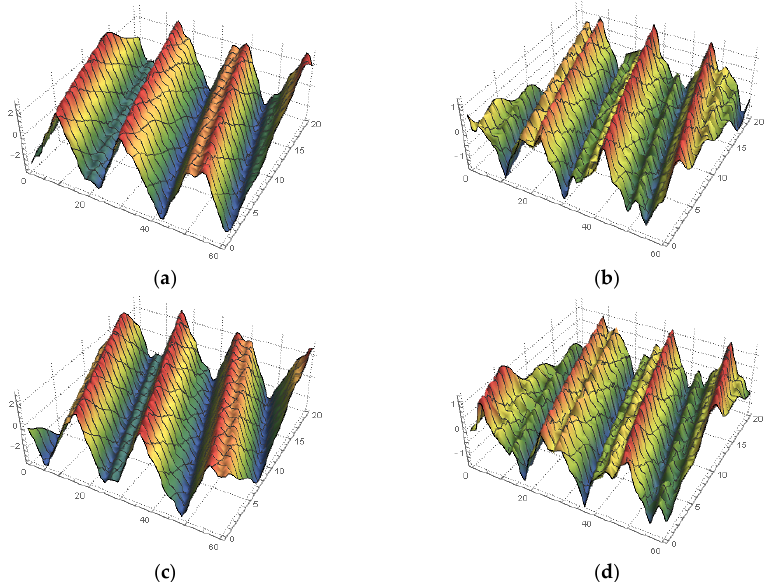
Figure 6. The 3D plots of the real and imaginary parts of F 10 ( x , t ) and G 10 ( x , t ) with the parameters r 1 = r 2 = 0.3, k 1 = k 2 = 1, q 0 = 0.9, p 2 = 1, q 1 = − 0.2, ρ = 0.5 and τ = 0 for the fractional order α = 0.9: ( a ) Re [ F 10 ( x , t )] , ( b ) Re [ G 10 ( x , t )] , ( c ) Im [ F 10 ( x , t )] and ( d ) Im [ G 10 ( x , t )] .